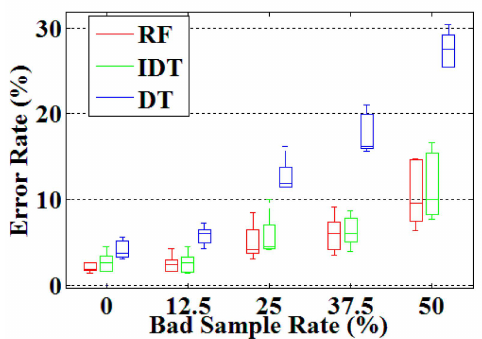
Figure 10. Results of robustness testing experiment. The horizontal axis denotes the proportion of bad samples in training set and the vertical axis denotes the error recognition rates of 121 CSL